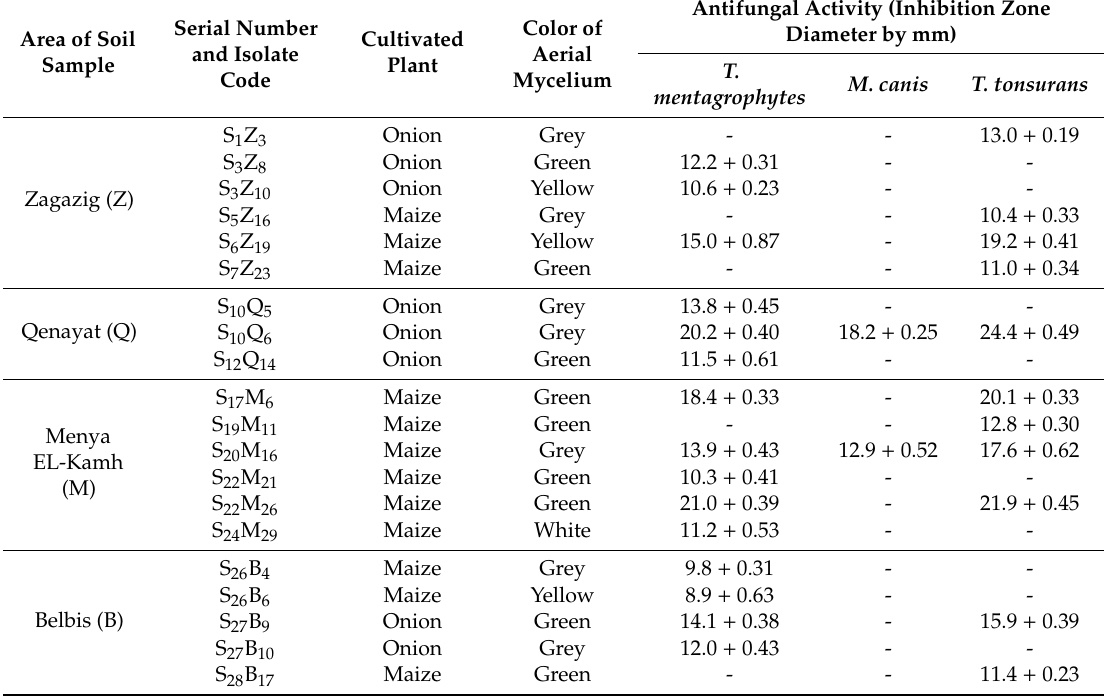
Table 1. Actinomycte isolates with antidermatophytic activity against the tested dermatophyte strains ( T. mentagrophytes , M. canis and T. tonsurans